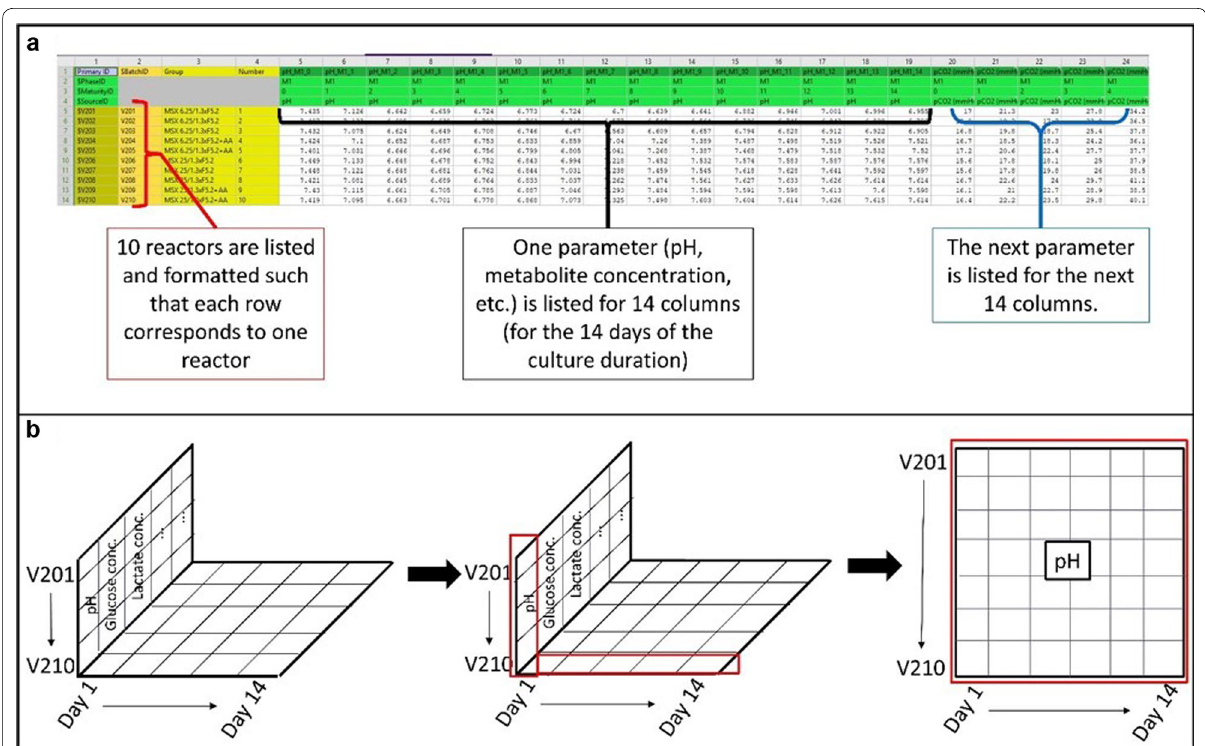
Fig. 1 Batch decomposition: a This is a direct capture of the methodology that the data are uploaded into SIMCA. Each row contains the data from one reactor (i.e., V201, V202, etc.). Each column contains data for a parameter such as pH, metabolite concentration, or other parameter for a given time point. b This shows the methodology that a batch evolution model (BEM) is converted to a batch level model (BLM). The first matrix shown on the far left represents the method that the BEM has stored the data as shown in a . Then, the second matrix (middle) shows how the BLM takes a portion of this matrix in the form of capturing the data for a single parameter (such as pH or a given metabolite concentration). Finally, the matrix on the right shows how the data for a BLM are inputted into SIMCA. This final matrix shows that the matrix being analyzed by the BLM contains data for one parameter for all the batches for every time point. The BLM is capable of analyzing the multiple matrices that are produced via this methodology for each parameter that is being